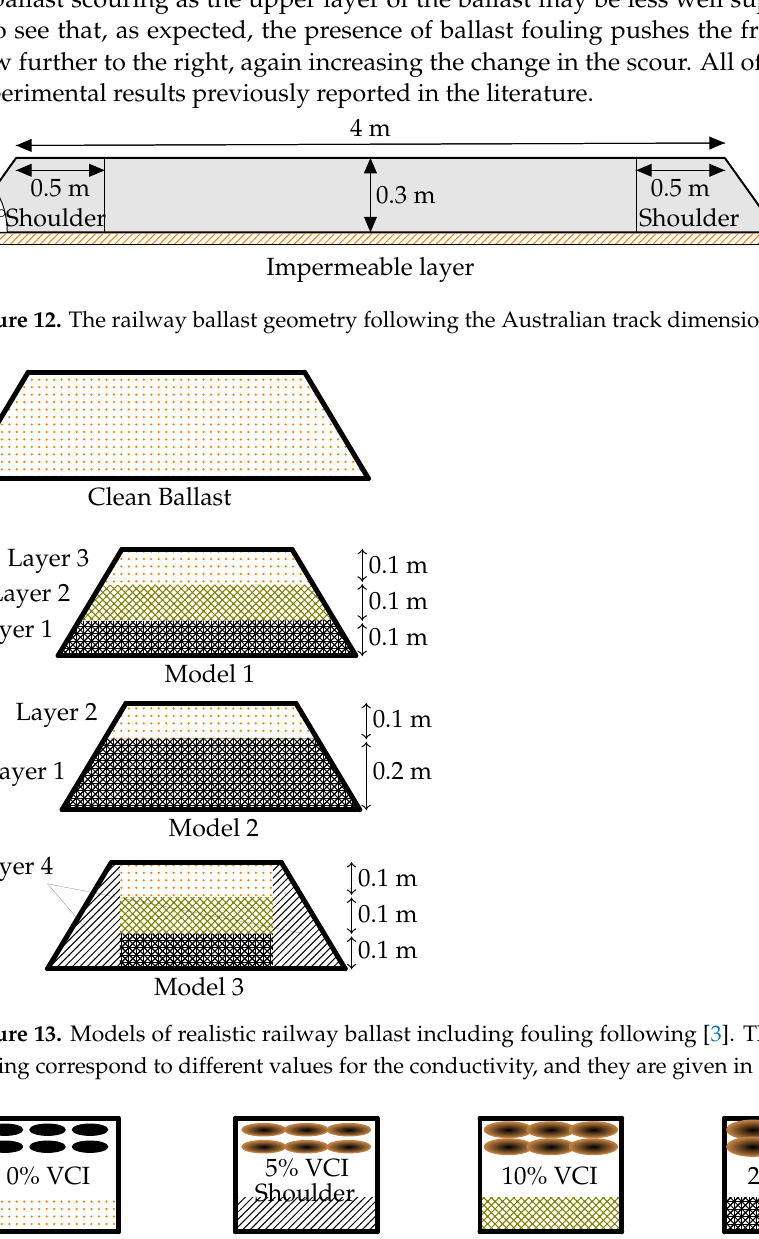
K s = 0.34 m/s Figure 14. Fouling ratio or VCI and the equivalent hydraulic conductivity K s . The lower portion of these figures shows the corresponding colouring used in Figure